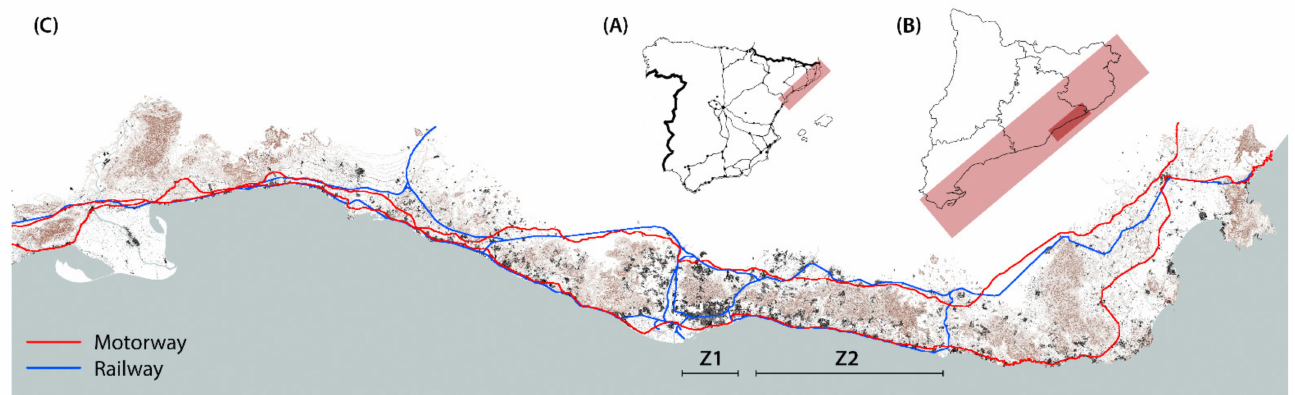
Figure 1. Index map of the Catalan coast and location of the Maresme region (Z2) in relation to Barcelona (Z1) (Source: authors’ own). ( A ) Location of the Catalan coast in Spain. ( B ) Location of the Maresme region on the Catalan coast. ( C ) Index map detail: topography, hydrography, urban settlements and transport